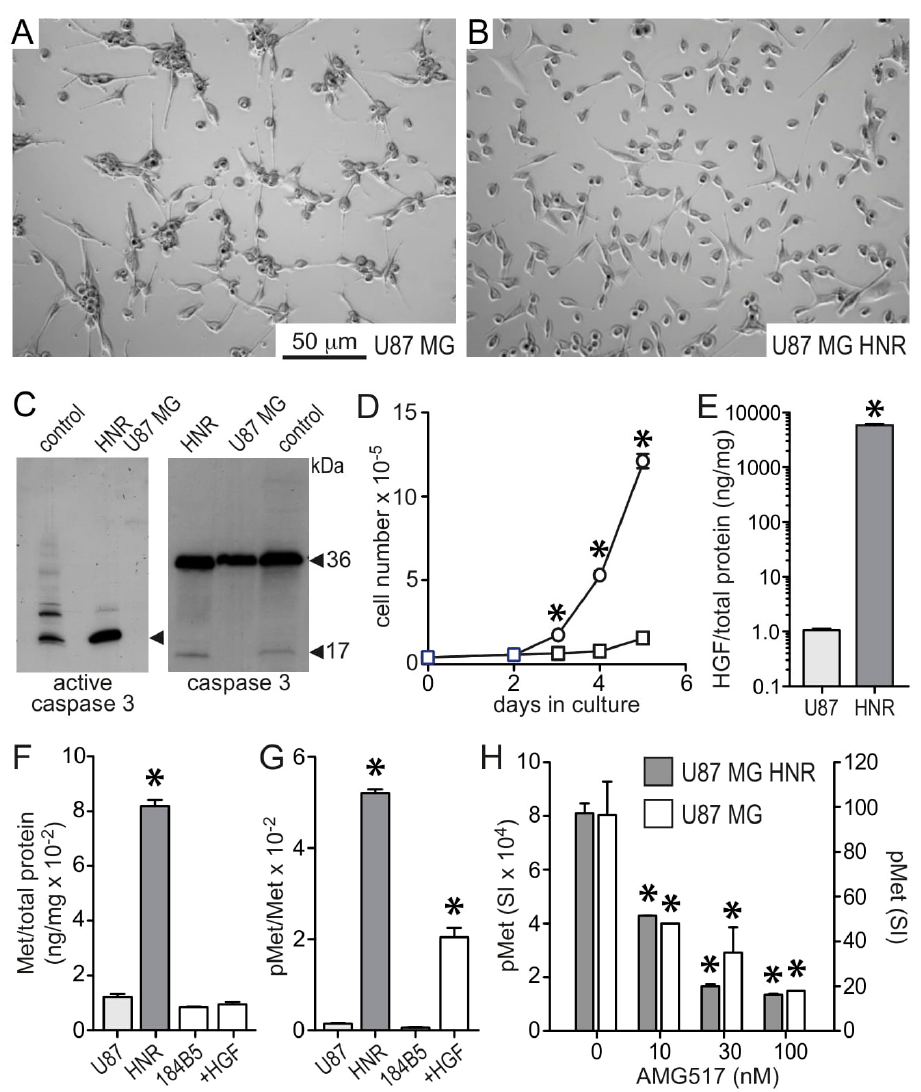
Figure 1. U87 MG and U87 MG/HNR cell morphology, proliferation, HGF, Met and phospho-Met content. Light micrographs of U87 MG ( A ) and U87 MG/HNR cells ( B ) in log growth phase. ( C ) Reduced SDS-PAGE and immunoblot analysis of U87 MG and U87 MG/HNR (“HNR”) cell extracts for activated caspase 3 (17 kDa, left panel) and total caspase 3 protein (36 kDa, right panel). Lanes marked “control” contain positive control proteins for active or intact caspase 3 provided by the antibody manufacturer. ( D ) Growth rates of U87 MG (squares) and U87 MG/HNR cells (circles) in culture (mean cell number ± SD, n = 3). ( E ) Secreted HGF protein (mean ng/mg total protein ± SD, n = 3) present in 24 h media from cultured U87 MG (light gray bar, left) or U87 MG/HNR cells (dark gray bar, right). ( F ) Total Met protein content (mean ng Met/mg total protein ± SD, n = 3) of U87 MG (light gray bar), U87 MG/HNR (dark gray bar) and serum-deprived 184B5 normal human mammary epithelial cells (white bars) in the absence (left) or presence of 1 nM HGF (right). ( G ) Phospho-Met (pMet) content (mean phosphoMet/total Met signal intensity ratio per mg total protein ± SD, n = 3) of U87 MG (light gray bar), U87 MG/HNR (dark gray bar) and serum-deprived 184B5 cells (white bars) in the absence (left) or presence of 1 nM HGF (right). ( H ) Phospho-Met (pMet) content (mean phosphoMet/total Met signal intensity ratio per mg total protein ± SD, n = 3) of U87 MG/HNR (gray bars, left Y-axis) and U87 MG (white bars, right Y-axis) in the absence (0) or presence of indicated concentrations (nM) of AMG517, a selective small-molecule Met kinase inhibitor. Asterisks indicate a significant difference from control ( p < 0.05). All the whole western blot figures can be found in the supplementary materials.